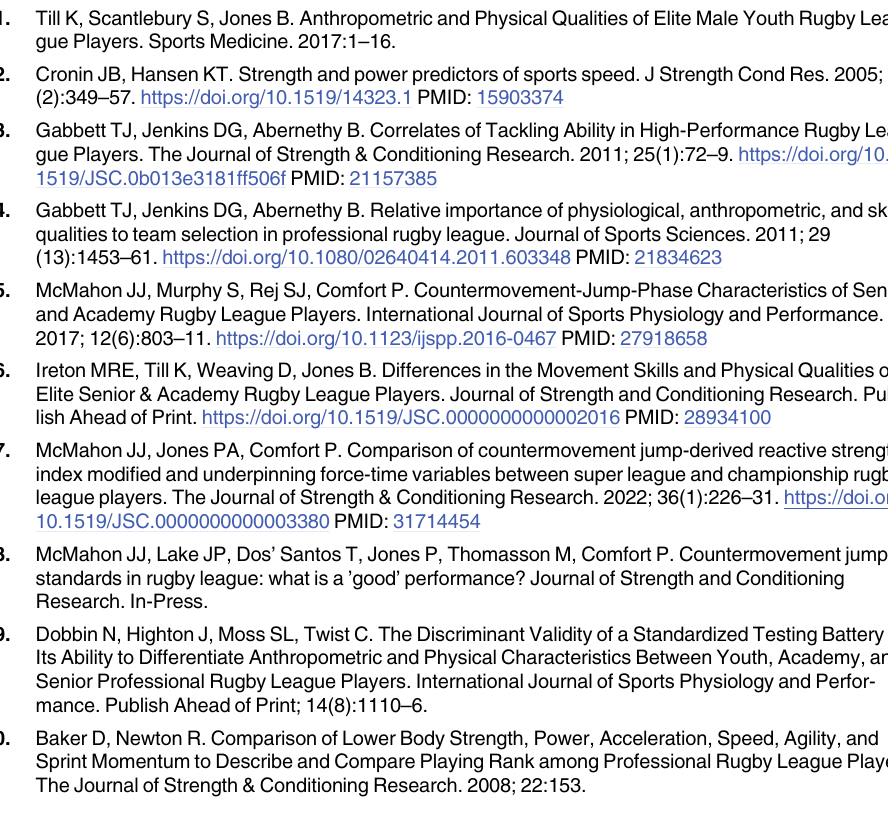
S1 Table. The jump data for forwards (n = 27) and backs (n = 27) that was taken forward for statistical analyses. RSImod = reactive strength index modified and BW =